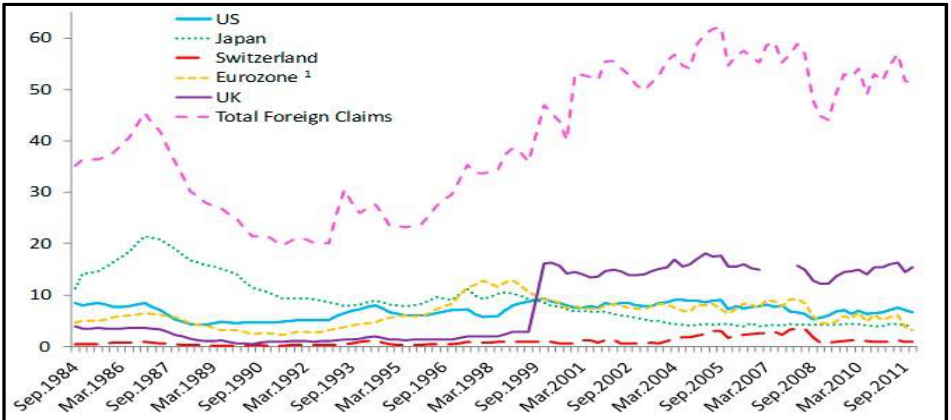
Figure 1: Total Foreign Bank Claims on Malaysia (in percent of Malaysian